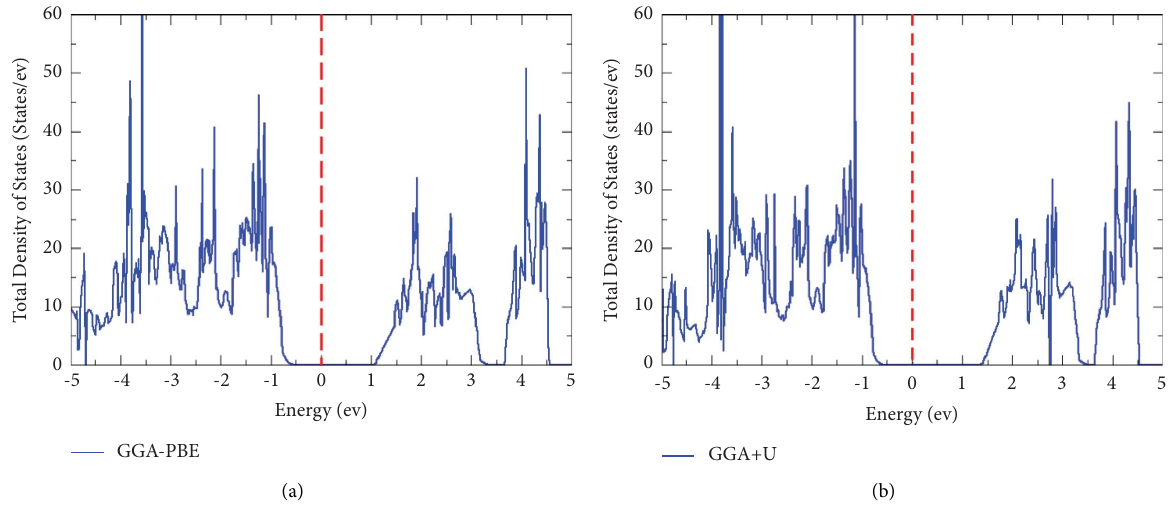
Figure 3: Total density of states of CaHfS 3 with respect to GGA-PBE (a) and GGA +U (b).